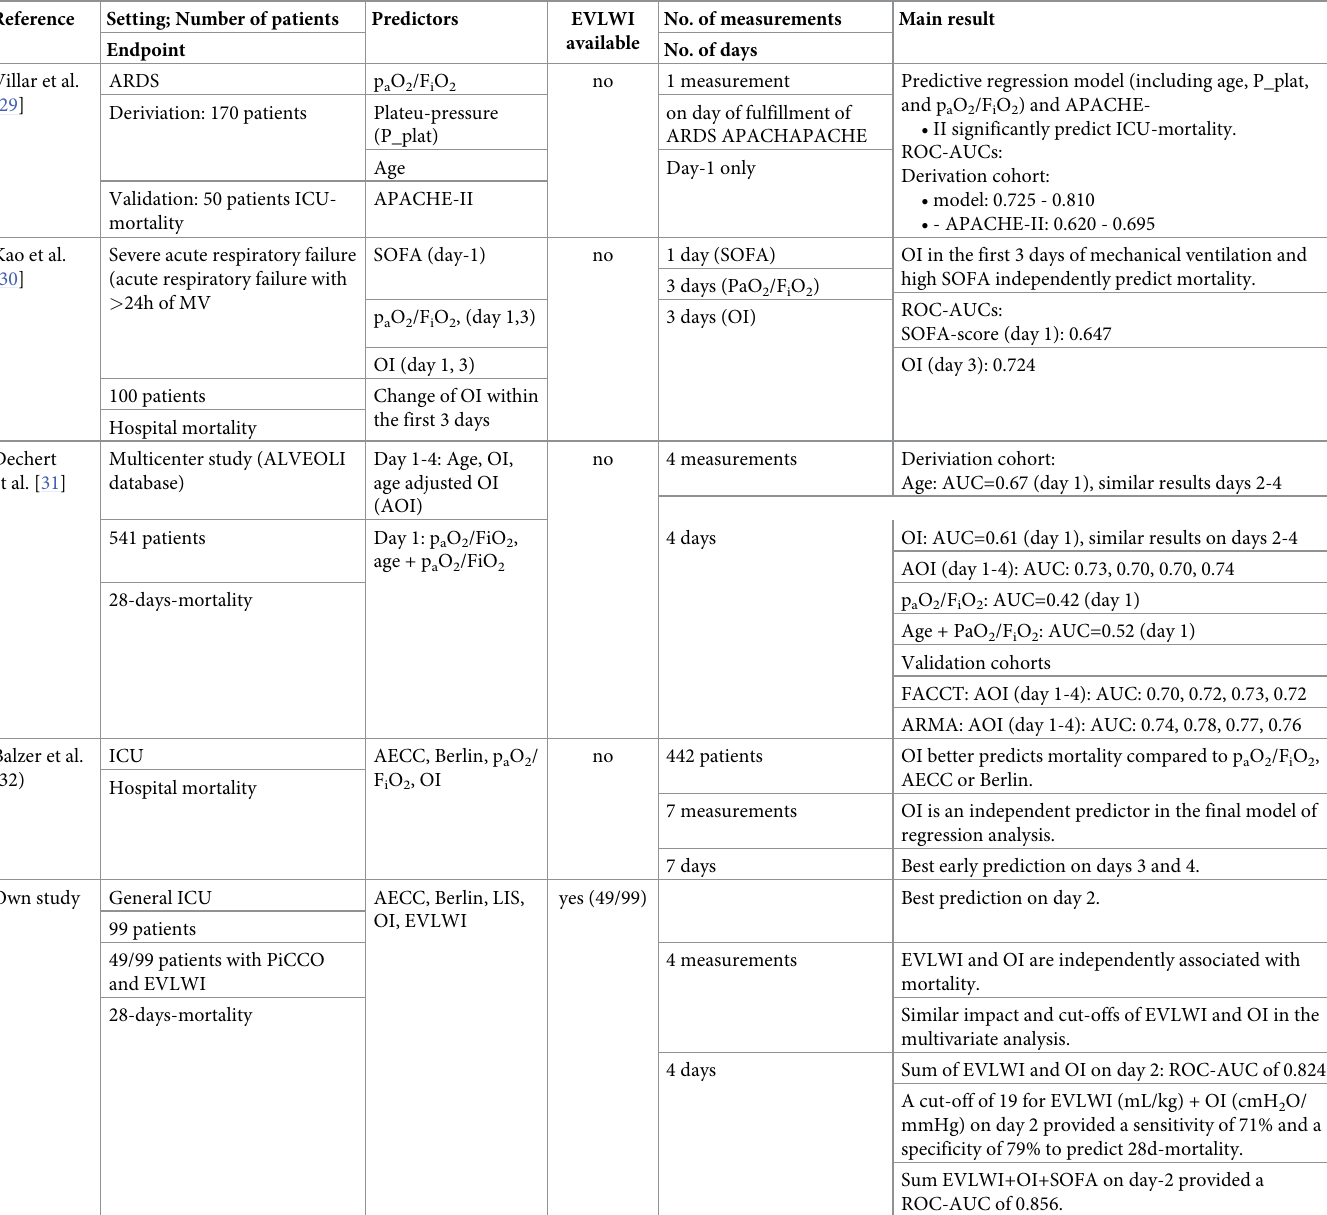
Table 1. Summary of studies comparing repeated prediction of outcome in acute respiratory distress syndrome